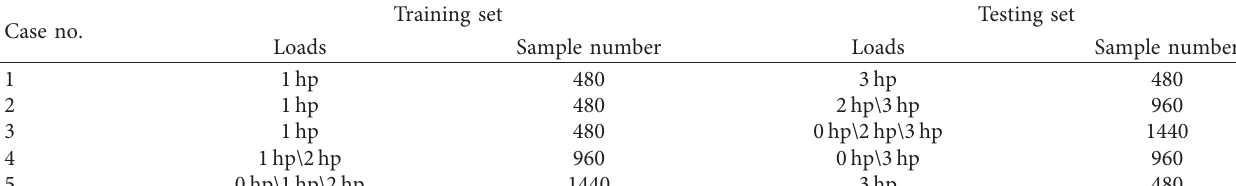
Table 2: The data constitutions of these five cases.